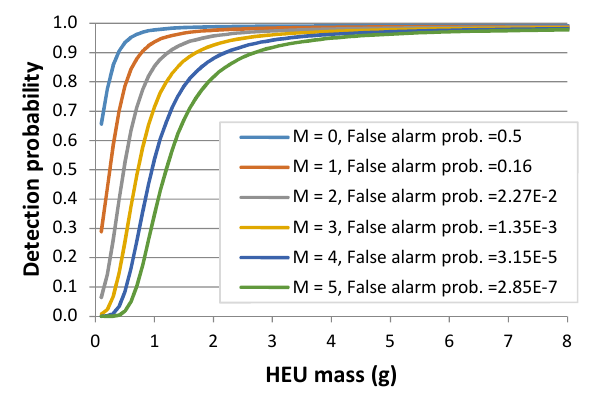
Fig. 15. Illustration of the background distribution and the distribution after addition of a source.